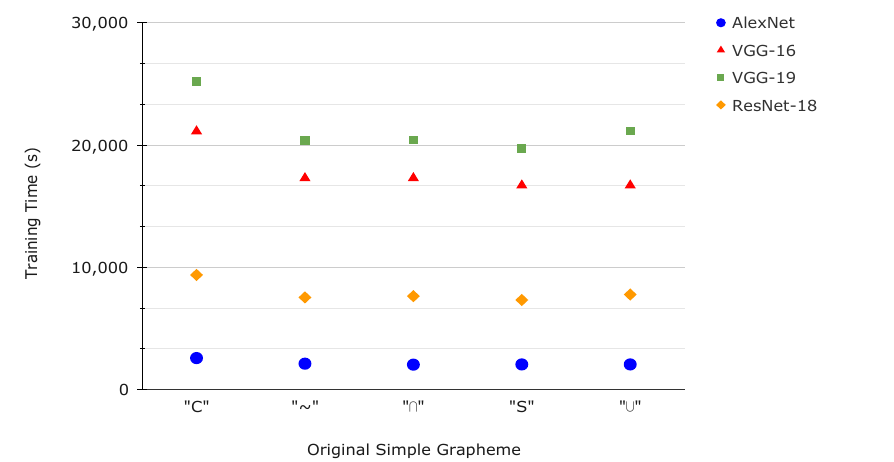
Figure 12. Original Simple Grapheme Training Time with AlexNet, VGG-16/VGG-19 and ResNet-18